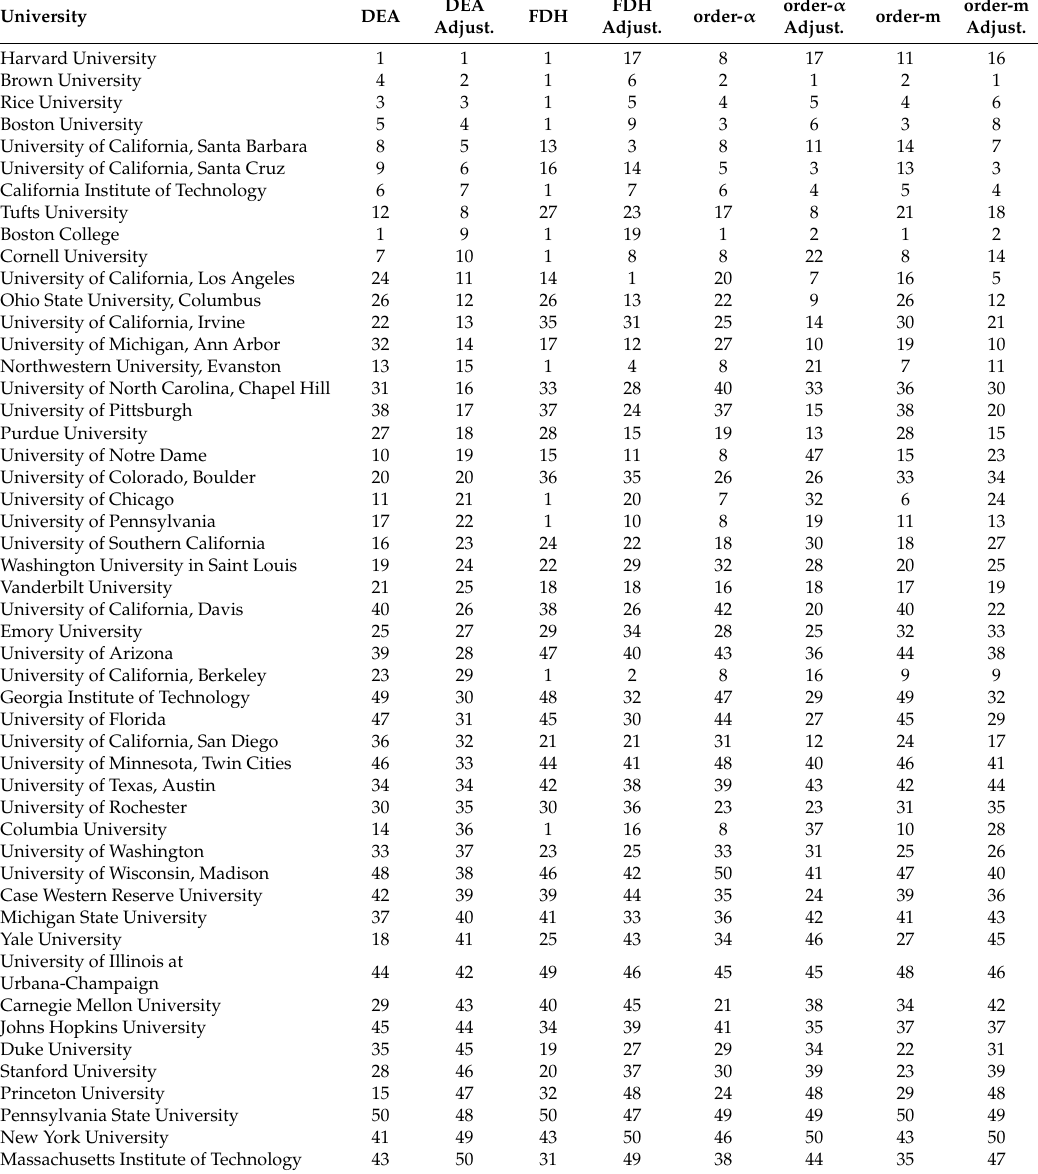
Table 6. Initial efficiency rank positions and adjusted rank positions in 2013 (sorted by adjusted DEA